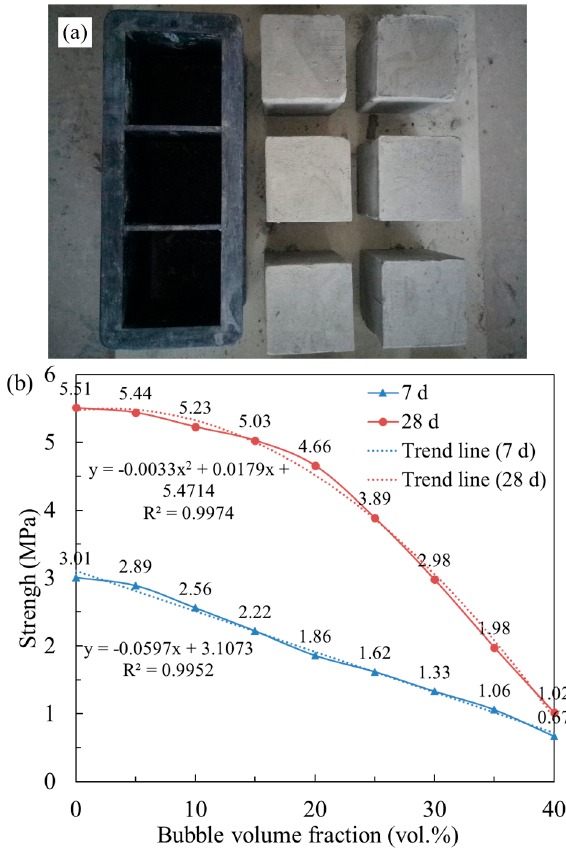
Figure 7. Results of strength tests: ( a ) method and ( b ) results.